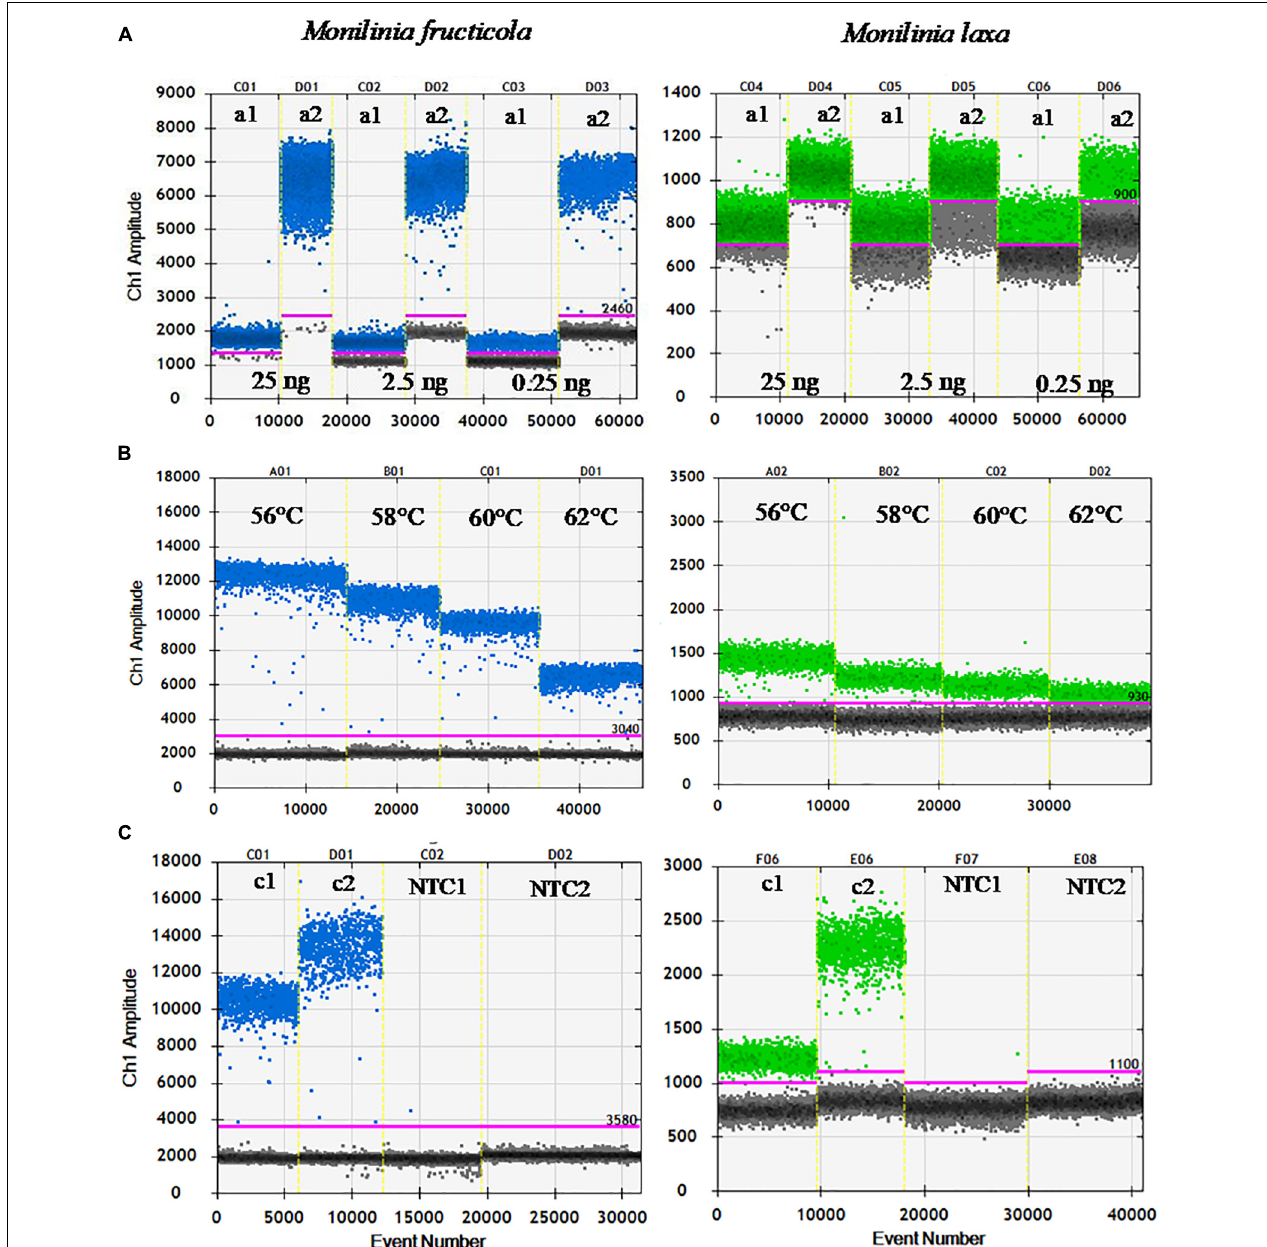
FIGURE 1 | Optimization of ddPCR parameters. (A) Primers/probe concentration [240/160 nM (a1) and 500/250 nM (a2)], using 25, 2.5, and 0.25 ng of M. fructicola (Mfrc) and M. laxa (Mlax) DNAs, at 62 ◦ C of annealing temperature, and 40 PCR cycles. (B) Annealing temperatures (56, 58, 60, and 62 ◦ C) using 2.5 ng of Mfrc and Mlax DNA, 500/250 nM of primers/probe concentration, and 40 PCR cycles. (C) PCR cycles number [40 (c1) and 50 (c2)] using 2.5 ng of target DNA, 500/250 nM of primers/probe concentration and 58 ◦ C as annealing temperature. NTC, no template control. Blue and green dots represent the positive droplets, above the pink horizontal threshold, for ddPCR with FAM (Mfrc) and HEX (Mlax) probes, respectively. Gray dots represent the negative